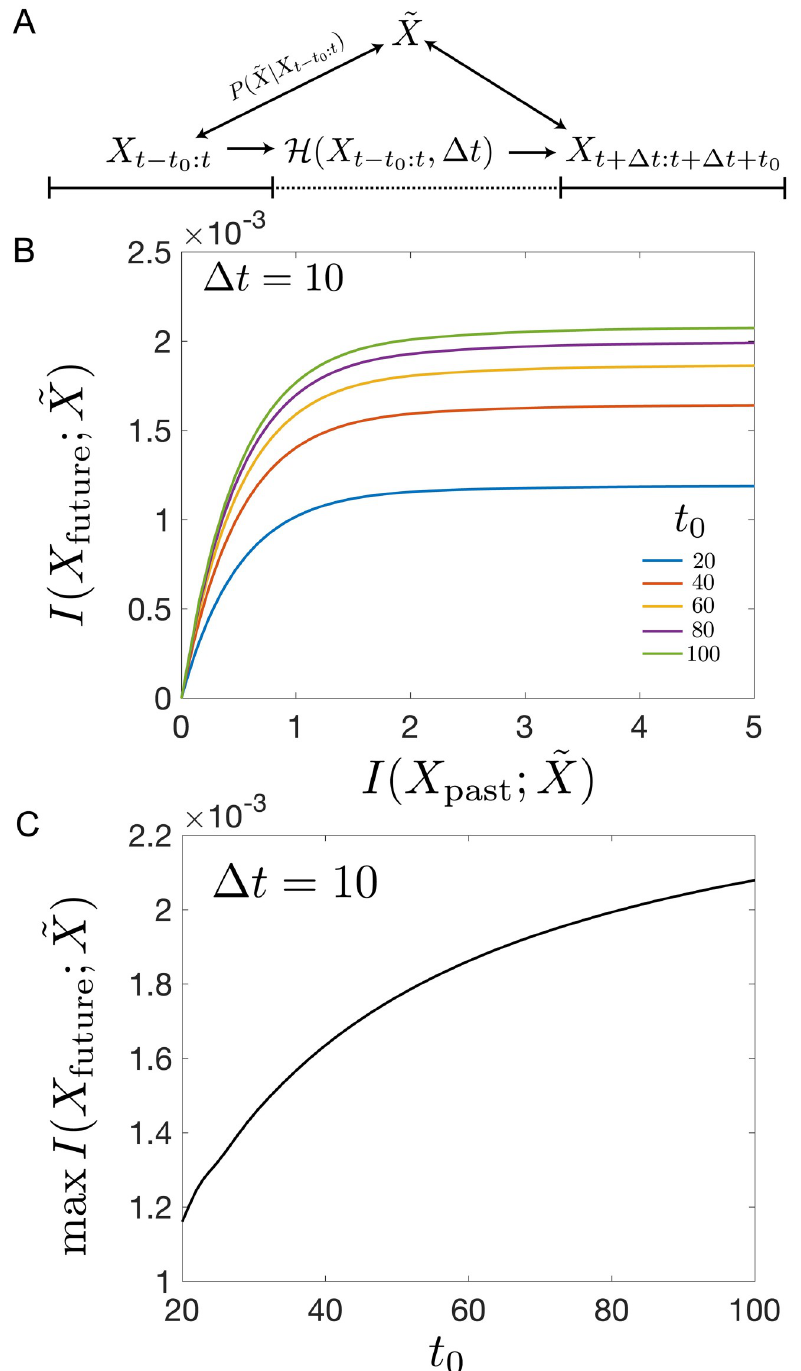
Fig 7. The ability of the information bottleneck Method to predict history-dependent stimuli. (a) The prediction problem, using an extended history and a future. This problem is largely similar to the one set up for the SDDHO but the past and the future are larger composites of observations within a window of time t − t 0 : t , expressed as X past for the past and t + Δ t : t + Δ t + t 0 , expressed as X future for the future. (b) Predictive information I ð X (c) The maximum available predictive information saturates as a function of the historical information used t 0 .